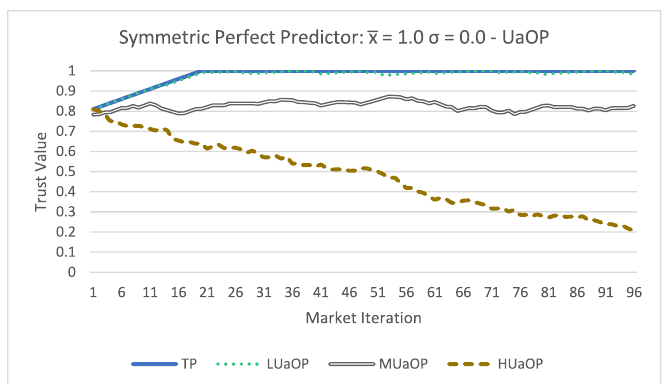
Figure 4. Symmetric Perfect Predictor.